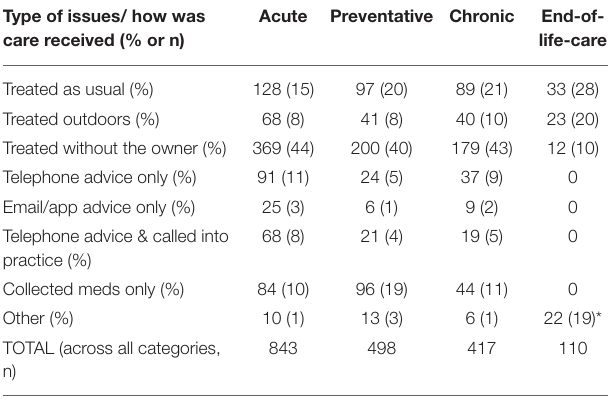
TABLE 5 | Comparison of how care for acute, preventative, chronic health issues and end-of-life health issues was received during the COVID-19 pandemic (%, n ). Type of issues/ how was care received (% or